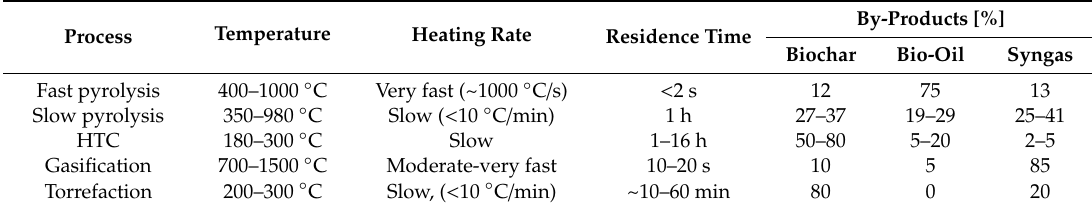
Table 1. Thermal conversion processes and products distribution